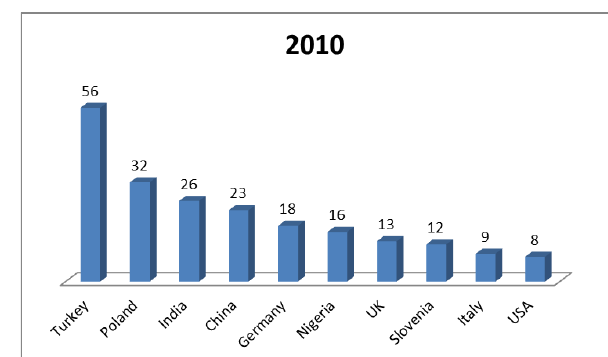
Figure 2. Number of members by geographical region.